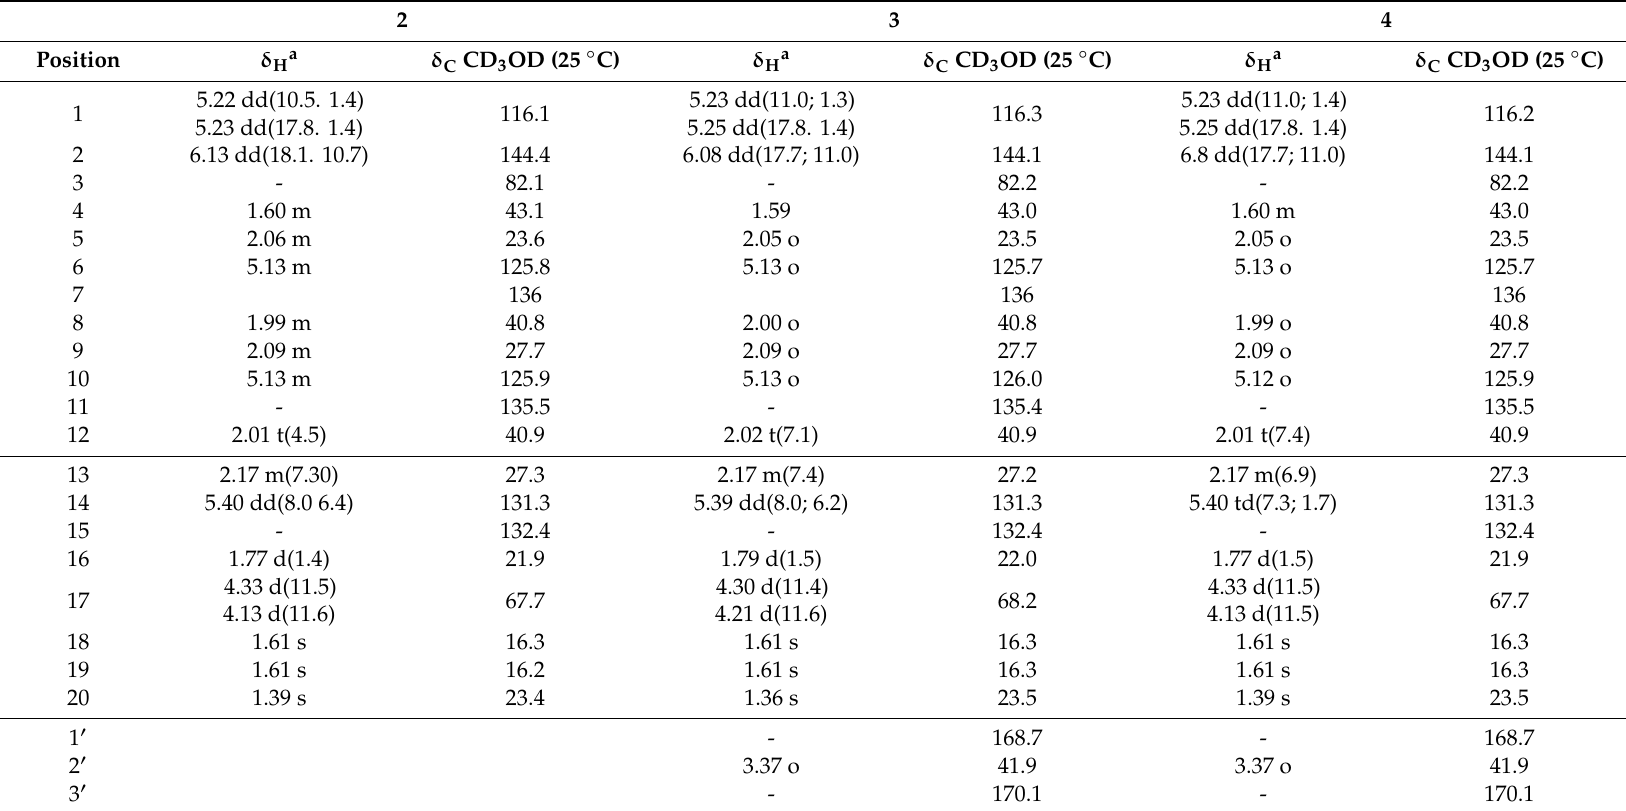
Table 3. 1 H- and 13 C-NMR Analysis of compounds 2–4